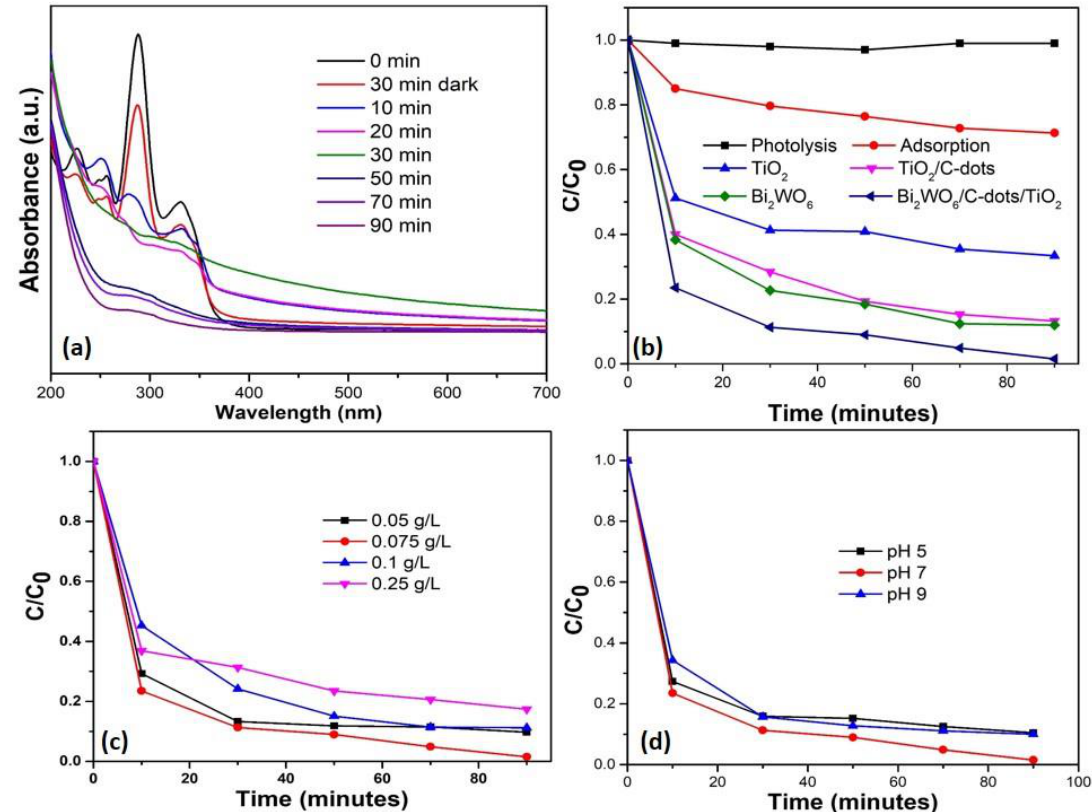
Figure 6. ( a ) Time-dependent UV-vis absorbance spectra of levofloxacin (10 mg/L, pH 7) under sunlight with Bi 2 WO 6 /C-dots/TiO 2 (0.075 g/L). ( b ) Assessment of photolysis, adsorption and photocatalytic efficiency of Bi 2 WO 6 /C-dots/TiO 2 with bare Bi 2 WO 6 , TiO 2 and TiO 2 /C-dots (catalyst dose 0.075 g/L, pH 7, Conc. of drug 10 mg/L. ( c ) Effect of variation in catalyst dose (Bi 2 WO 6 /C-dots/TiO 2 ) on photocatalytic degradation of drug. ( d ) Effect of change in pH of levofloxacin solution on photocatalytic behavior of Bi 2 WO 6 /C-dots/TiO 2 (dose 0.075 g/L) under sunlight.